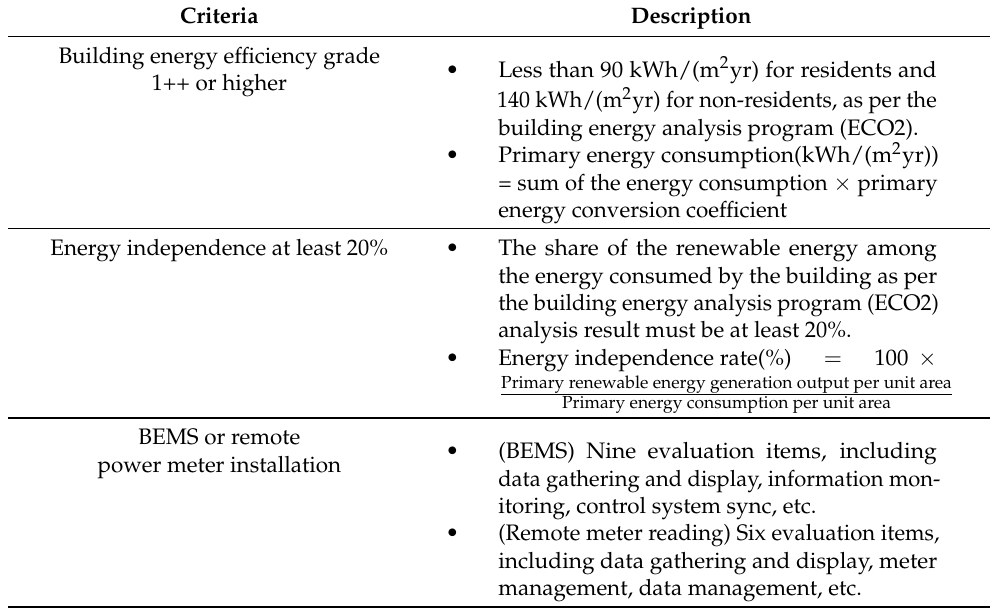
Table 4. South Korea’s nZEB certification program